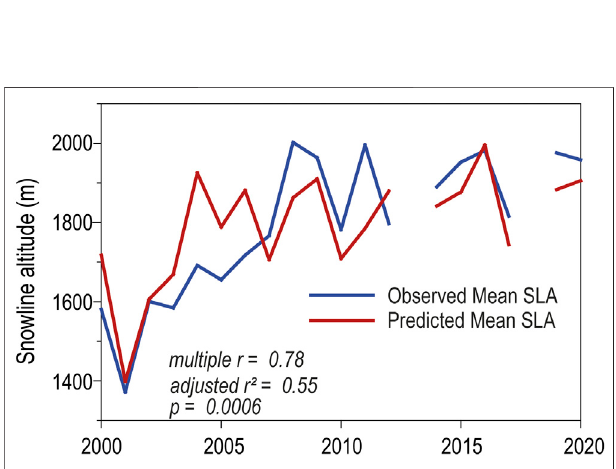
FIGURE 9 | Observed (blue) and predicted (red) snowline altitudes as a function of March temperatures and December-January precipitation.